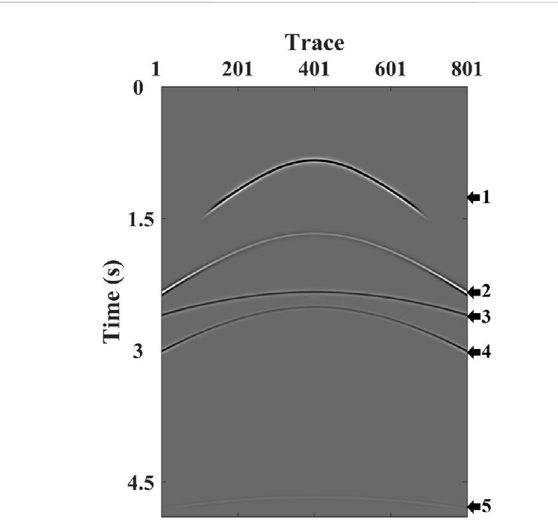
FIGURE 6 The simulated common shot gather. Arrows 1,2,4 represent the primary, fi rst-order multiple and second-order multiple associated with the fi rst layer. Arrows 3,5 represent the primary and fi rst-order multiple waves associated with the second layer.